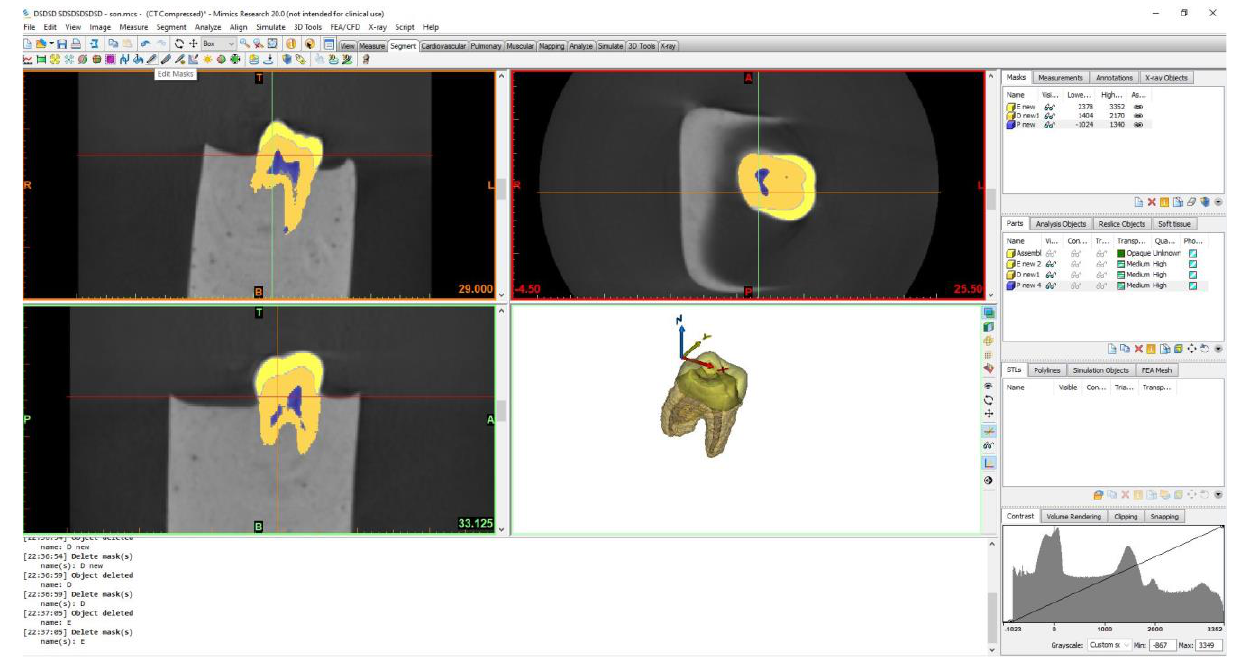
Figure 2. CBCT-scan data as seen in MIMICS 12. The tooth is presented in three different cross- sectional views.